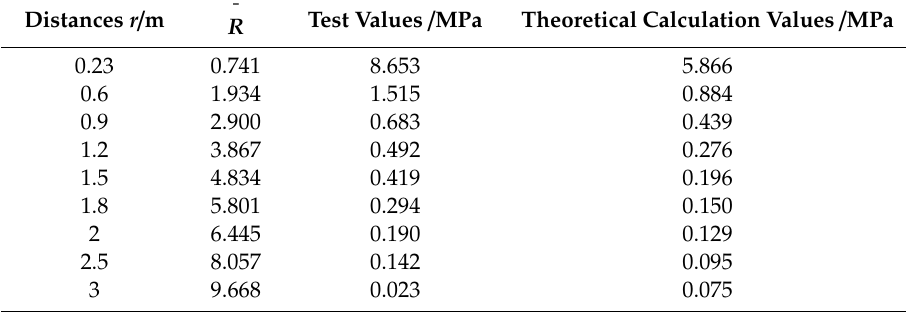
Table 3. Peak pressure test values and theoretical calculation values at di ff erent distances and contrast